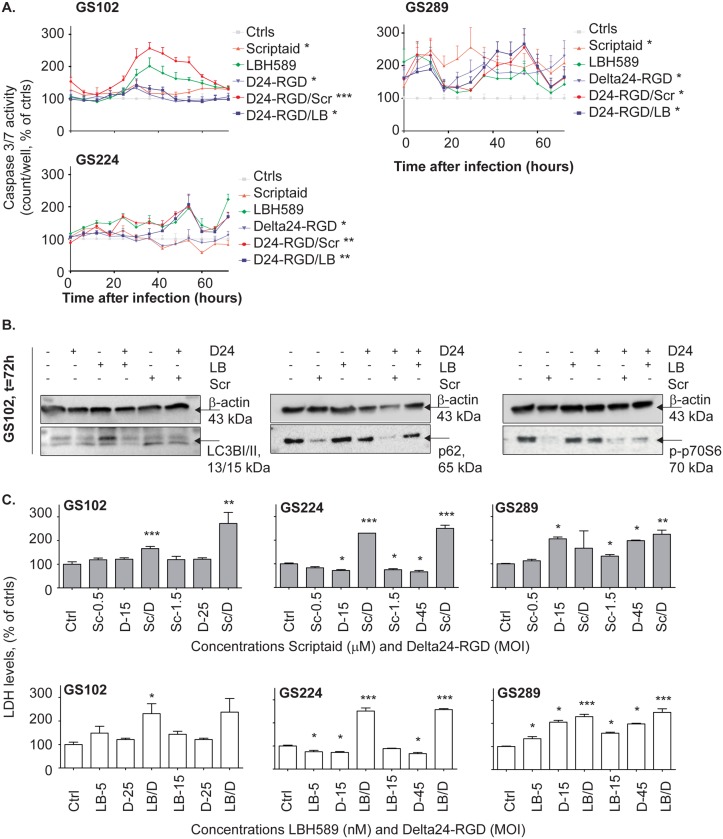
Affected cell death mechanisms in HDACi/Delta24-RGD treatment.(A) The cells of GS102, GS224 and GS289 cells were concomitantly treated with HDACi and Delta24-RGD. Caspase-3/7 activity was measured using caspase-3/7 apoptosis assay and the IncuCyte system and counts/well are shown *Indicates significance at p<0.05 for single treatments compared to non-treated controls ± standard deviation; and **/*** Indicates significance at p<0.05 for the combination treatments compared to controls (**) and the two single agent treatments (***). (B) The cells of GS102 were concomitantly treated with HDACi and Delta24-RGD. After 72 hours, the cells were harvested and LC3BI/II, p62 and phospho-p70SK levels were determined by Western blot analysis. Beta-actin was detected as a loading control. (C) The cells of GS102, GS224 and GS289 cells were concomitantly treated with Scriptaid (upper panel, grey) or LBH589 (lower panel, white) and Delta24-RGD. The LDH levels were determined using the CytoTox-One Assay reagent at five days post-treatment. Fluorescence was measured with the Tecan reader. The LDH levels are presented as percentage of non-treated controls ± standard deviation, corrected for viability. * Indicates significance at p<0.05 for the combination treatments compared to controls (**) and the two single agent treatments(***).